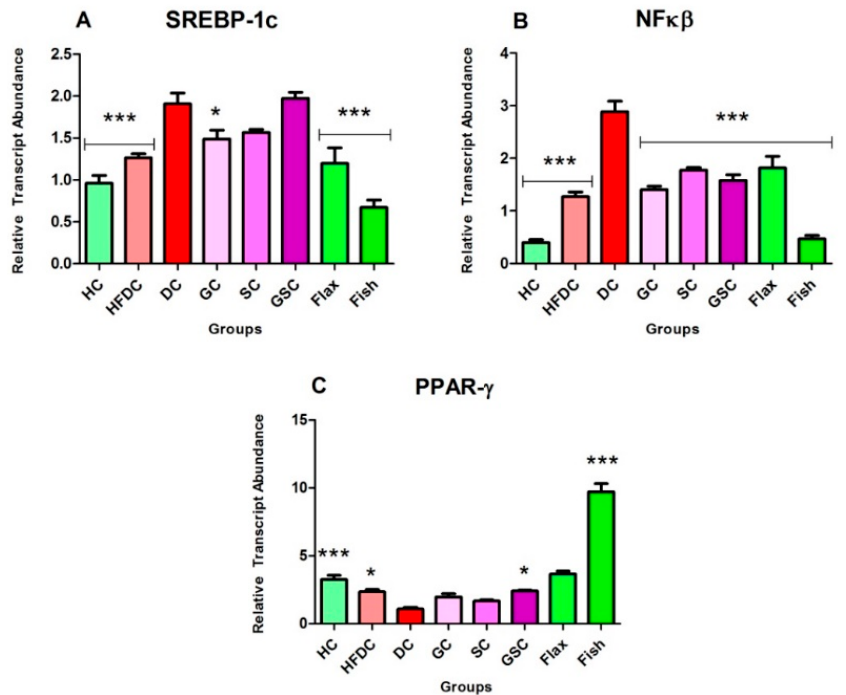
Figure 8. Expression of transcription factors are modulated after intervention of flax and fish oil. Results are represented as Mean ± SE ( n = 3 for each group). * p ≤ 0.05 and *** p ≤ 0.001, when compared with the DC group (Dunnett’s Multiple Comparisons Test). ( A ) Expression of sterol